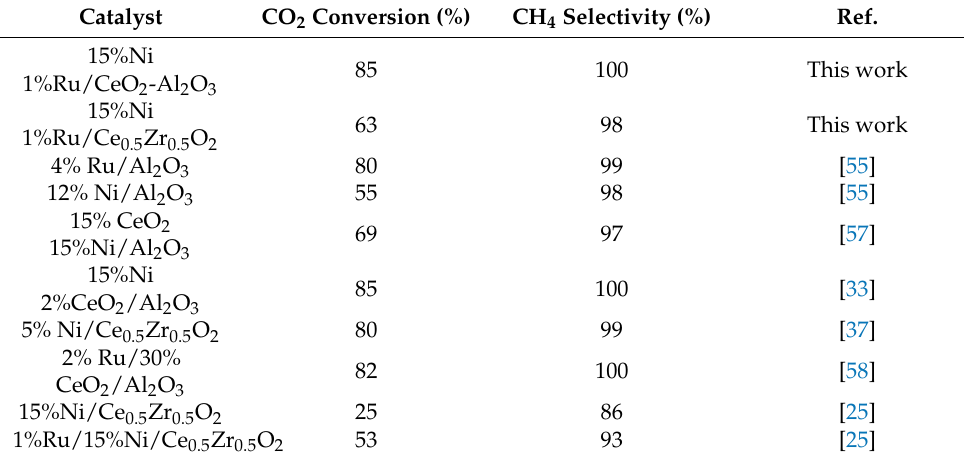
Table 1. Comparison of catalytic performance of Ni- and Ru-based catalysts at 350 ◦ C in the CO 2 methanation reaction as reported in the literature.